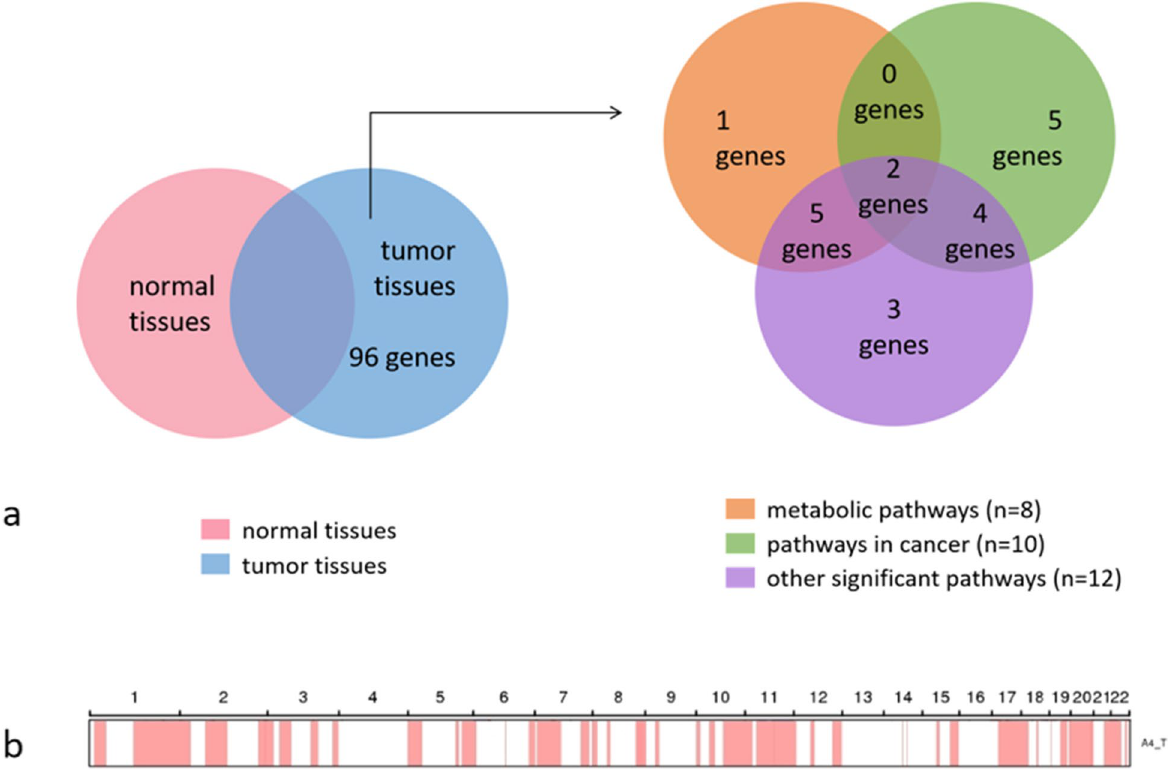
Fig. 4 Venn diagram of differential genes. Among all genes with single nucleotide polymorphisms, we identified genes with missense mutations that were detected in tumor-tissue samples but not in normal-tissue samples